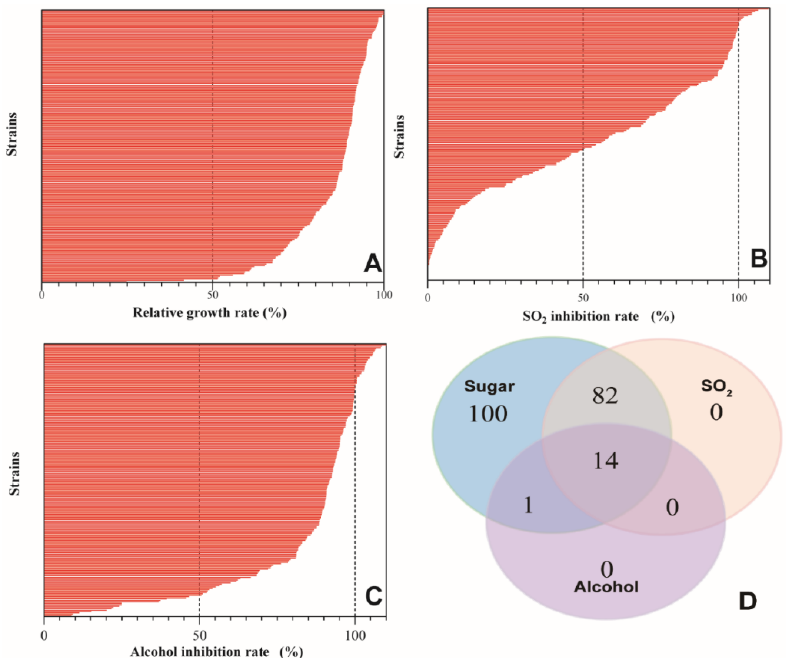
Figure 2. The tolerance analysis of the isolated S. cerevisiae strains to sugar, SO 2 , and ethanol (( A ): sugar tolerance, expressed as relative growth rate in synthetic grape juice containing 250 g/L glucose; ( B ): SO 2 tolerance, expressed as inhibition rate in synthetic grape juice containing 100 mg/L total SO 2 ; ( C ): ethanol tolerance, expressed as inhibition rate in synthetic grape juice containing 12% ( v/v ) alcohol; ( D ): Venn diagram of tolerance analysis of S. cerevisiae strains).